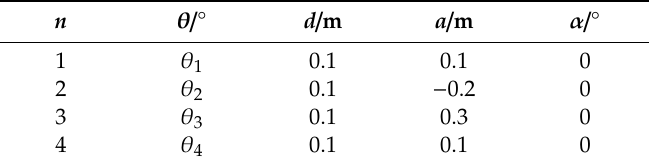
Table 9. The DH parameters of the robot with three parallel joints.